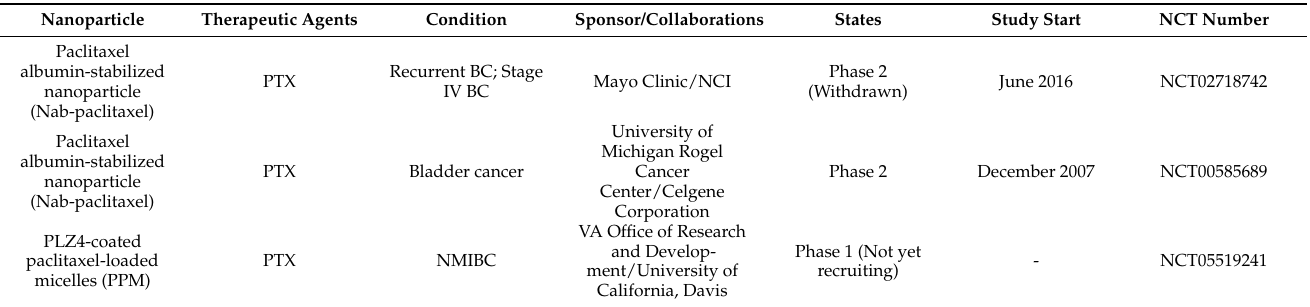
Table 3. Clinical trials for bladder cancer with nano-formulations in the United